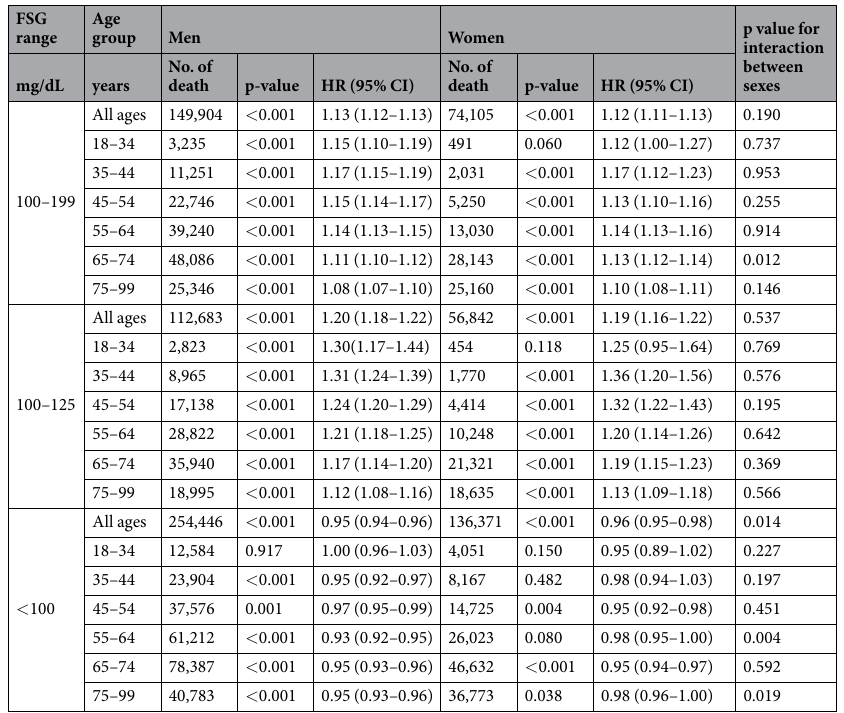
Table 2. HRs a per 18 mg/dL (1 mmol/L) FSG increase according to sex, age, and FSG range. CI, confidence interval; FSG, fasting serum glucose; HR, hazard ratio. a HRs were calculated by Cox models stratified by age (baseline age, years: 18–24, 25–34, 35–44, 45–54, 55–64, 65–74, 75–84, 85–99), after adjustement for age at baseline, sex (if applicable), smoking status, alcohol use, physical activity, body mass index, systolic blood pressure, and total cholesterol. To convert glucose from mg/dL to mmol/L, multiply by